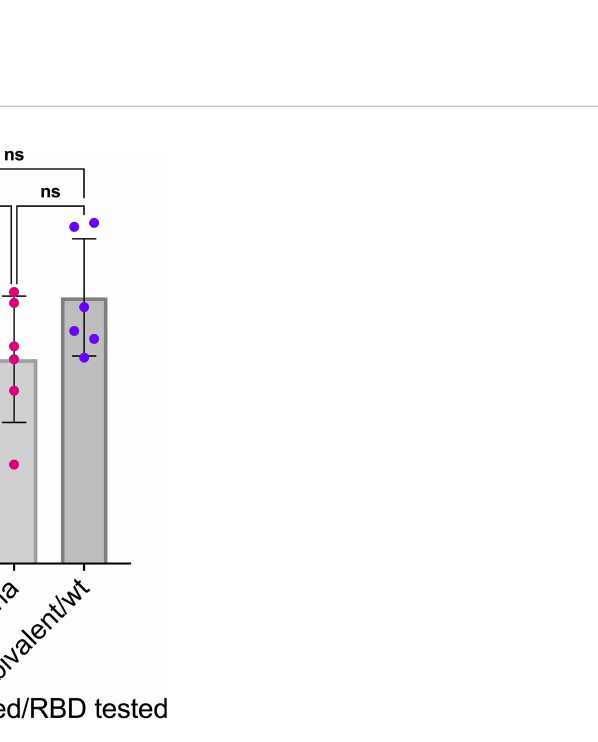
FIGURE 12 | Protection against lung infection with SARS-Cov-2 Delta variant correlates with serum SARS-CoV-2 Delta variant neutralization: Correlation between results of SARS-CoV-2 Delta variant neutralization test, results of neutralization antibody assay, and lung infection was assessed in infected K18-hACE2 transgenic mice of immunized Group 1 sacri fi ced at 3 dpi for lung collection (n= 8 with individual color code). (A) Simple linear regression between RBD Delta -ACE2 interaction inhibition rate at week 8 and log 10 PFU per gram of lung tissue at 3 dpi. Correlation is not signi fi cant ( p -value= 0.058, R= -0.69) and non-parametric Spearman correlation is also not signi fi cant (p-value= 0.083, R= -0.67). (B) Simple linear regression between log 2 (ND50/10) (or number of dilutions after initial 1:10 dilution) analyzed with the SARS-CoV-2 Delta variant neutralization test at week 8 and log 10 PFU per gram of lung tissue at 3 dpi. Correlation is signi fi cant ( p -value= 0.025, R= -0.77) and non-parametric Spearman correlation is more signi fi cant (p-value= 0.006, R= -0.89).